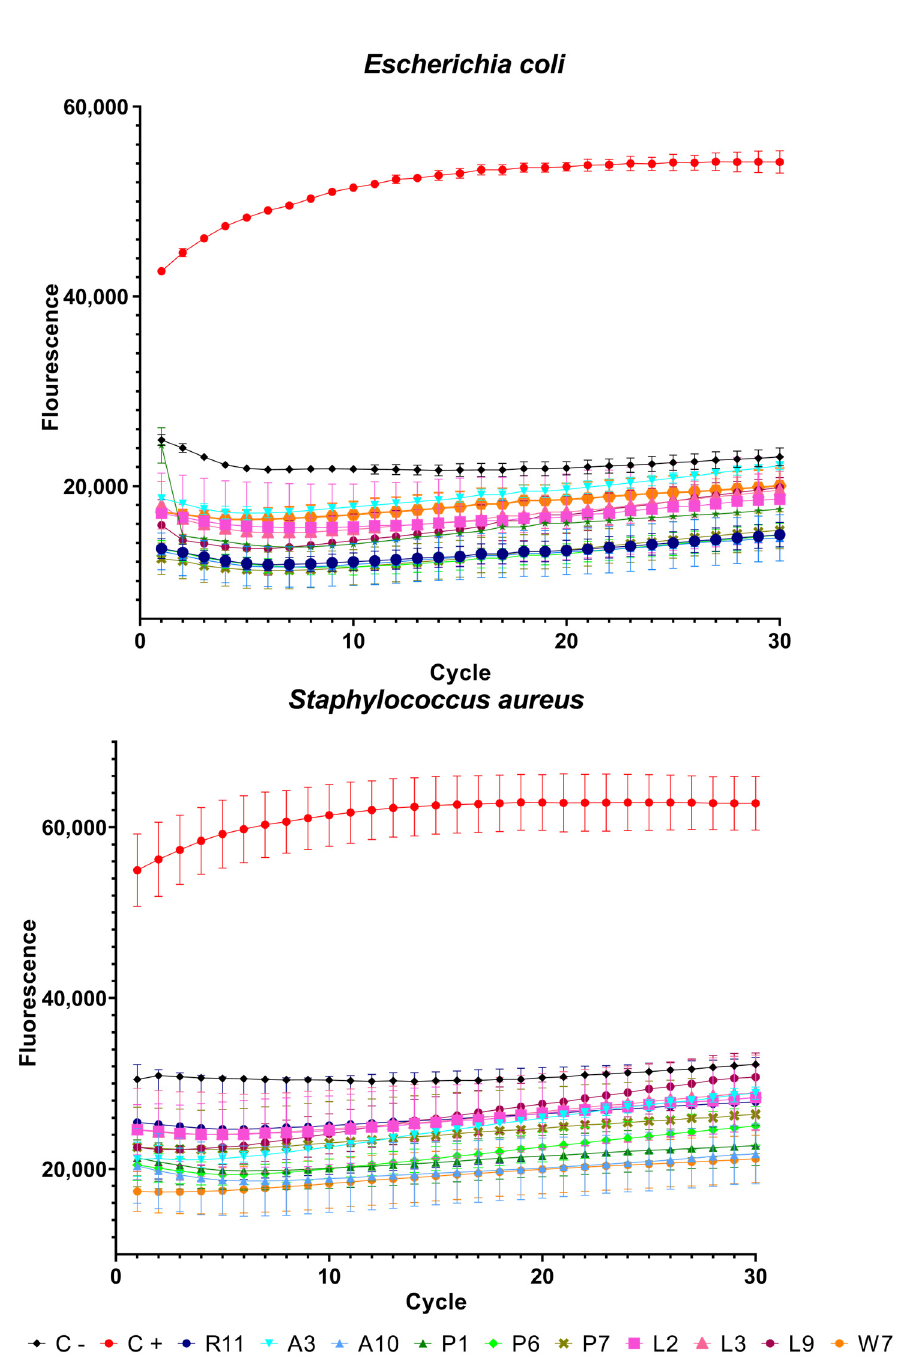
Figure 2. SYTOX green permeabilization assay. High fluorescence values indicate membrane permeabilization. Synthetic peptide KKWRWWLKALAKK was used as positive control.